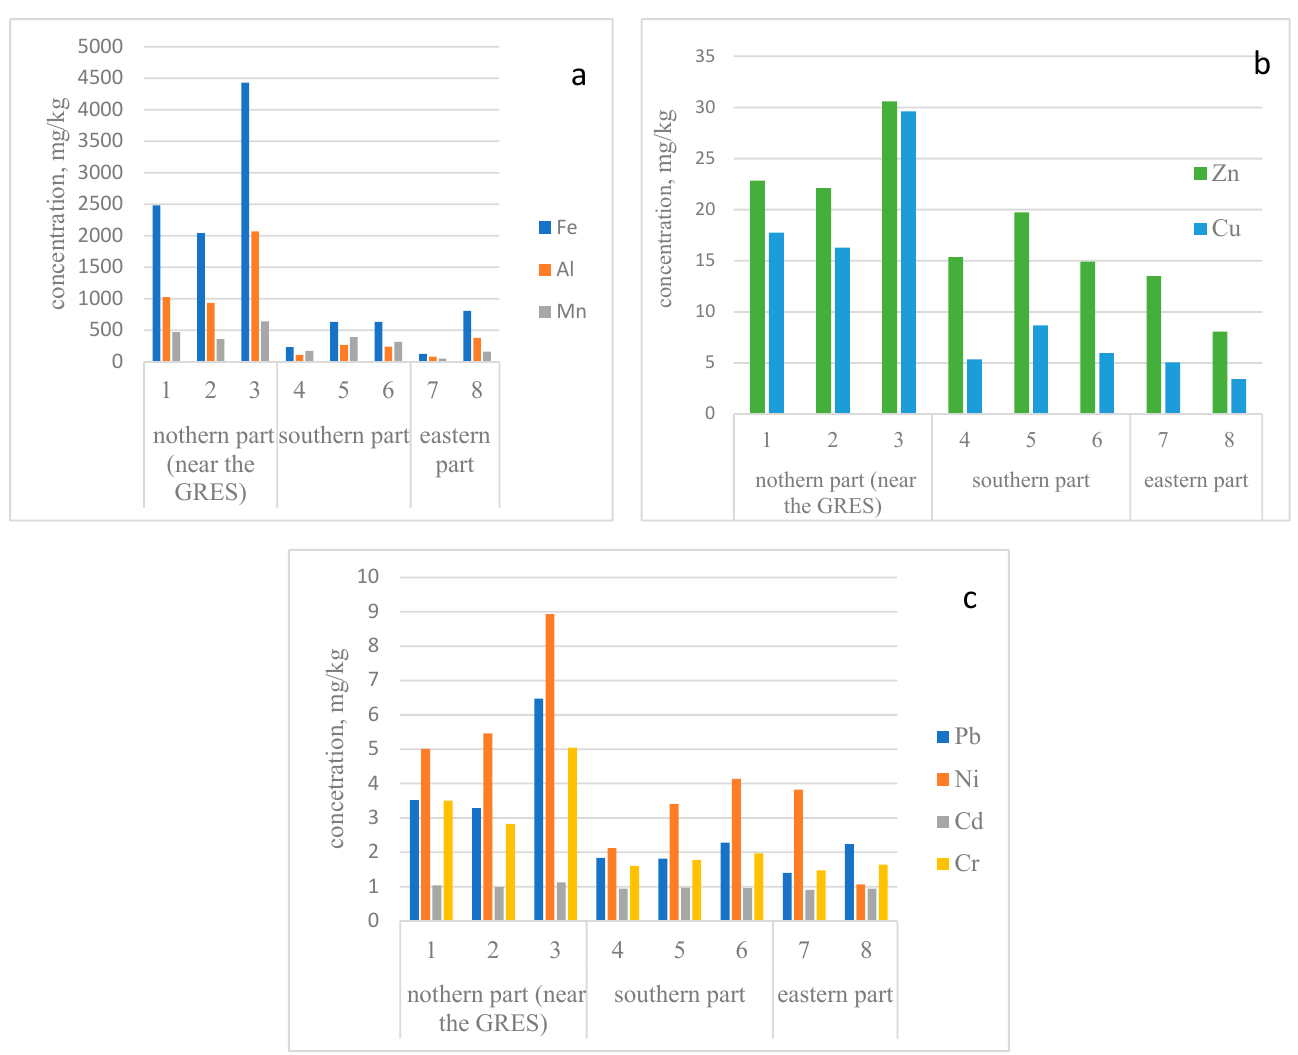
Figure 9. Content of metals in aquatic plants of Lake Gusinoe. Metal concentration, mg/kg dry weight: 1-water milfoil, Myriophyllum sp.; 2-waterweed, Elodea Canadensis ; 3-filamentous green algae, Chlorophyta; 4-water milfoil, Myriophyllum sp.; 5-pondweed, Potamogeton sp.; 6-water moss, Fontalis antipyretica ; 7-pondweed, Potamogeton sp.; 8-stonewort, Chara sp. ( a ) Fe Al Mn; ( b ) Zn Cu; ( c ) Pb Ni Cd Cr.